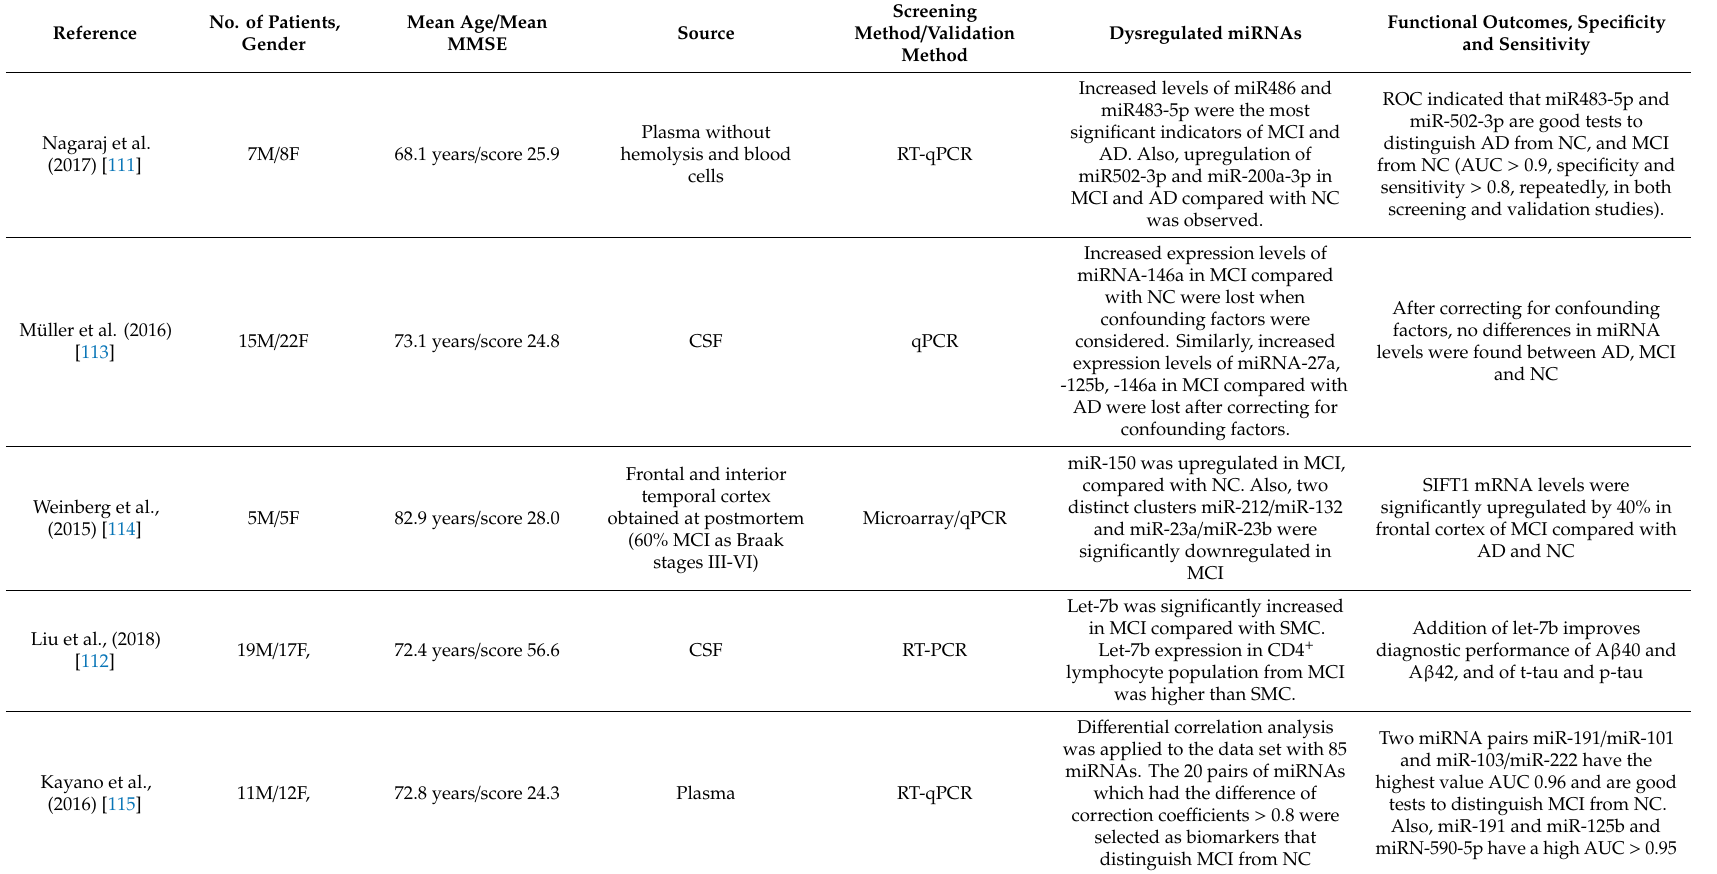
Table 4. MicroRNAs in human patients with AD or mild cognitive